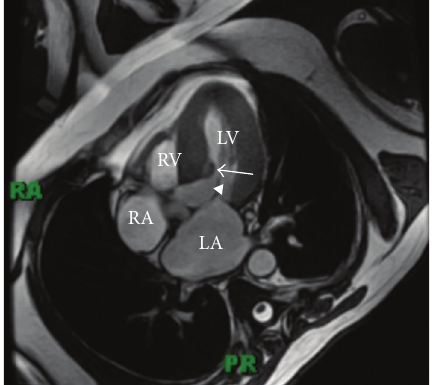
Figure 3: Preoperative Cardiac MR, 4-chamber view. LA: left atrium; LV: left ventricle; RA: right atrium, RV: right ventricle; arrow: interventricular septal mass; arrow head: left ventricular outflow